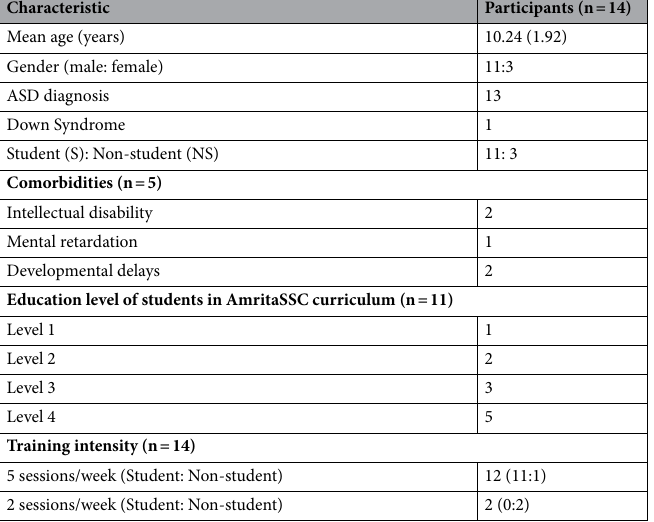
Table 1. Characteristics of